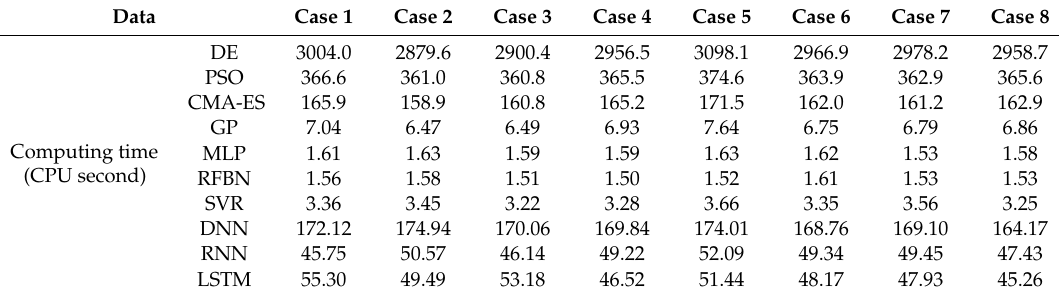
Table 9. Computing time for Jeju